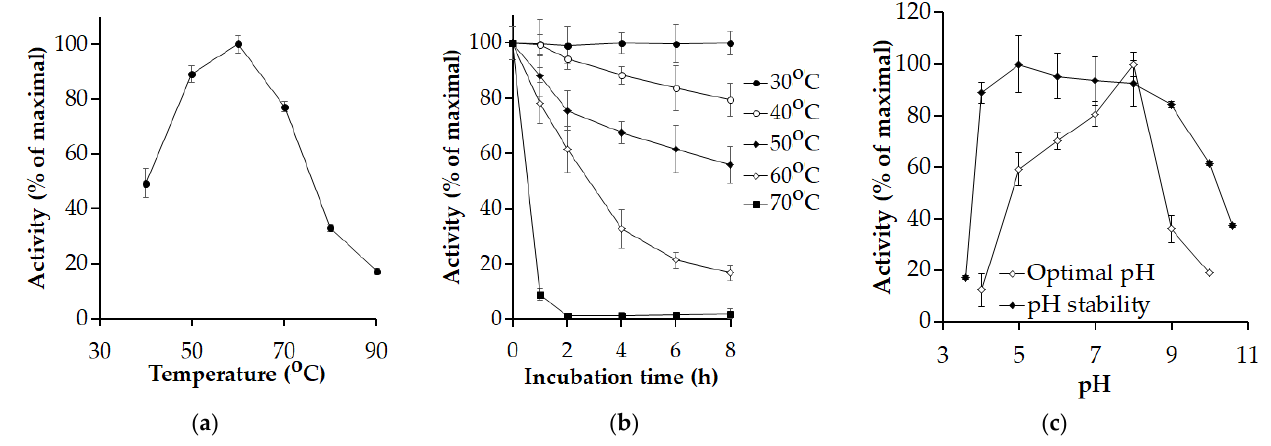
Figure 3. Effect of temperature and pH on the activity of P. elgii TKU051 protease. ( a ) optimal temperature; ( b ) thermal stability; and ( c ) optimal pH and pH stability. The error bars refer to the standard deviation of three replications.